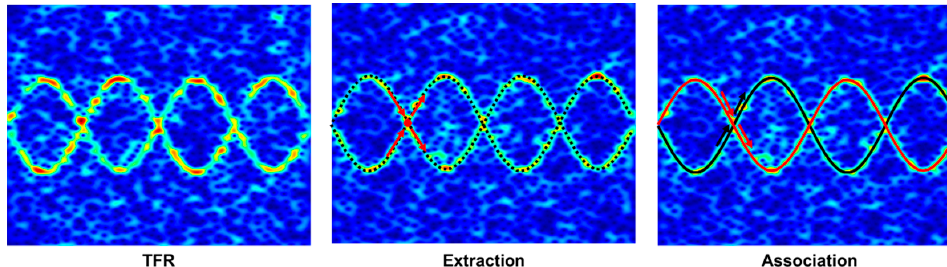
Figure 3. Extraction and Association Process.